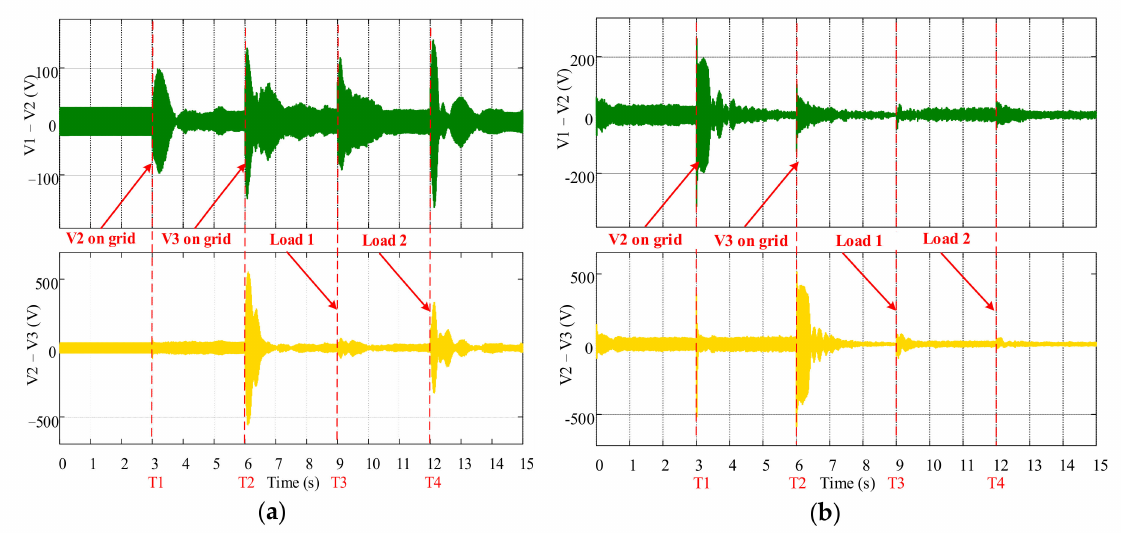
Figure 7. The voltage differences different control strategies under no-load conditions: ( a ) the traditional control strategy; ( b ) the proposed strategy.